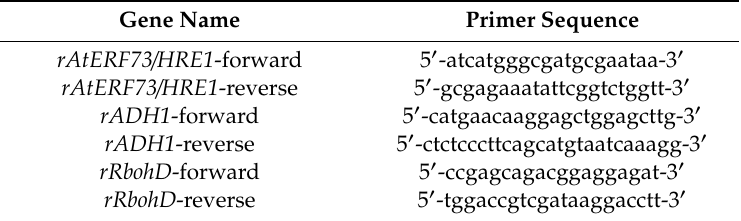
Table 1. Primers used for quantitative RT-PCR